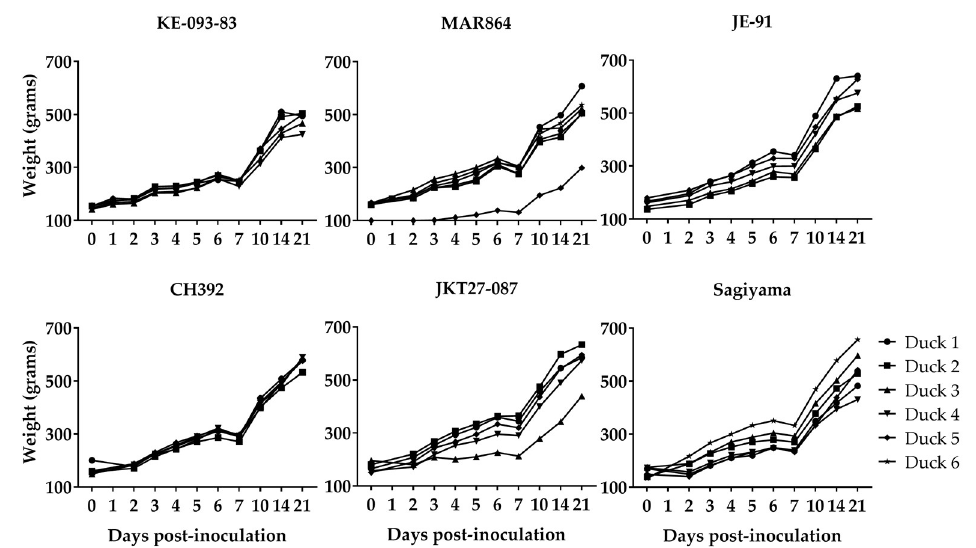
Figure 3. Body weight of ducklings inoculated with Japanese encephalitis viruses. Duckling 6 for both MAR864 and Sagiyama groups were non-inoculated controls.